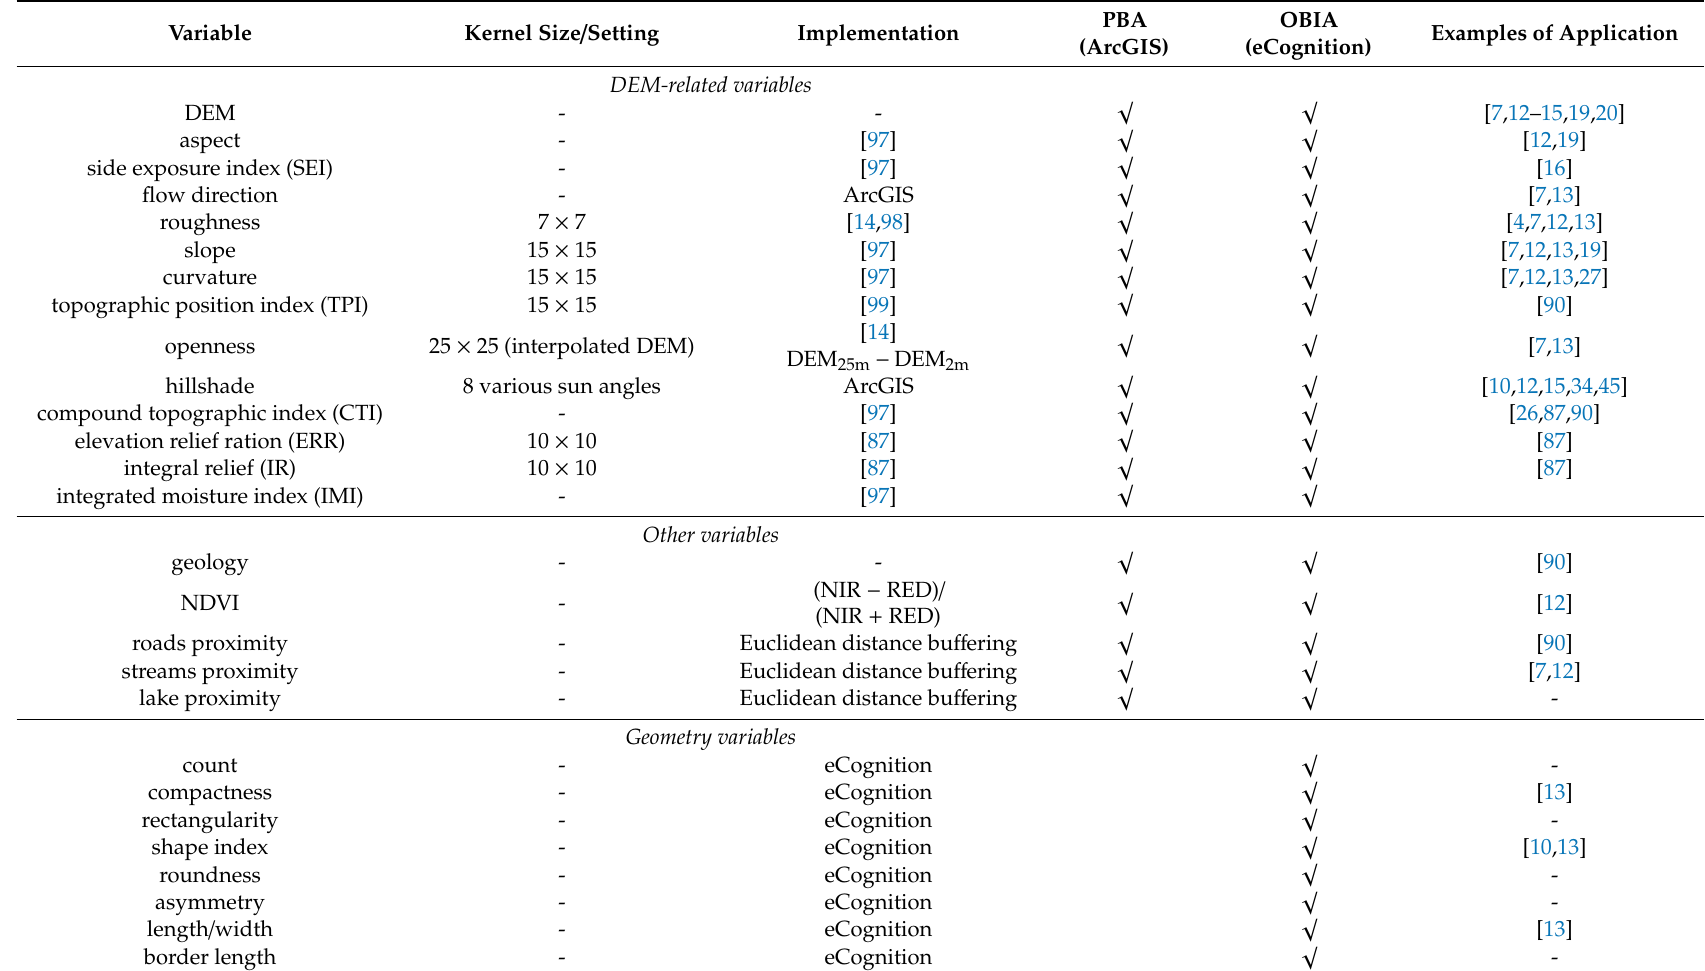
Table 2. Variables used for landslide detection with the setting, software, and methods utilized to calculate